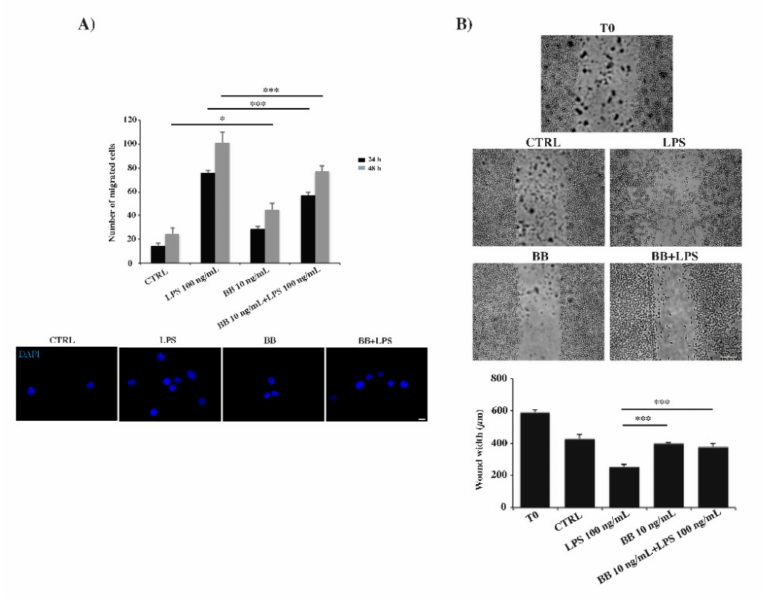
Figure 4. Analysis of cell migration determined by Boyden chamber assay ( A ) and scratch assay ( B ). Cells were treated with 10 ng / mL BB in the absence or presence of 100 ng / mL LPS. ( A ) Representative images of Boyden chamber assay using DAPI staining to mark the nucleus of cells migrated through the membranes. Bar: 200 µ m. Data were reported as total number of cells migrated, randomly taken from twenty fields from three di ff erent experiments made in triplicate. ( B ) Representative images of scratch assay. Bar: 200 µ m. Data were reported as mean of triplicate experiments ± SD. * p < 0.05 BB compared to control at 48 h, *** p < 0.001 compared to